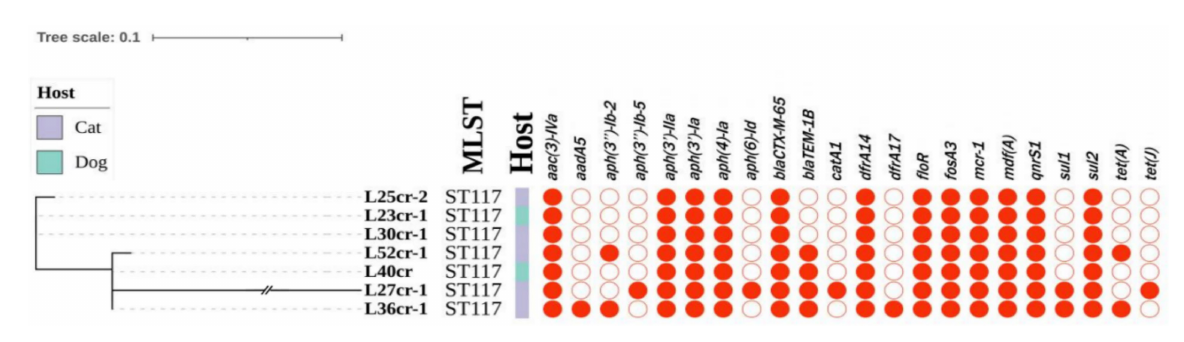
FIGURE 1 Phylogenetic tree (left) showing the genetic relationship, multi-locus sequence typing (MLST), and antimicrobial resistance genes of 7 mcr-1 - positive Escherichia coli isolates from seven non-duplicate samples (feces and wounds) obtained from 5 cats and 2 dogs at a pet hospital in